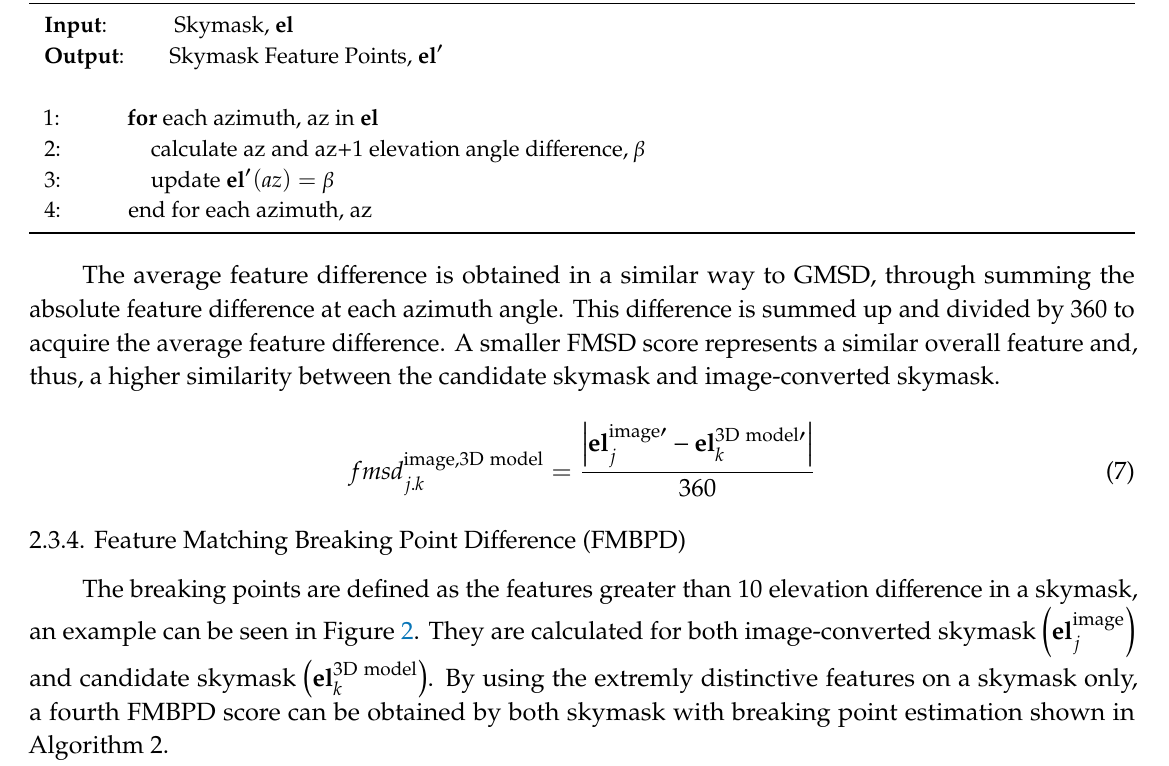
Figure 2. Comparison between the skymask and its feature points. Algorithm 1 Determining the Feature Points in a Skymask